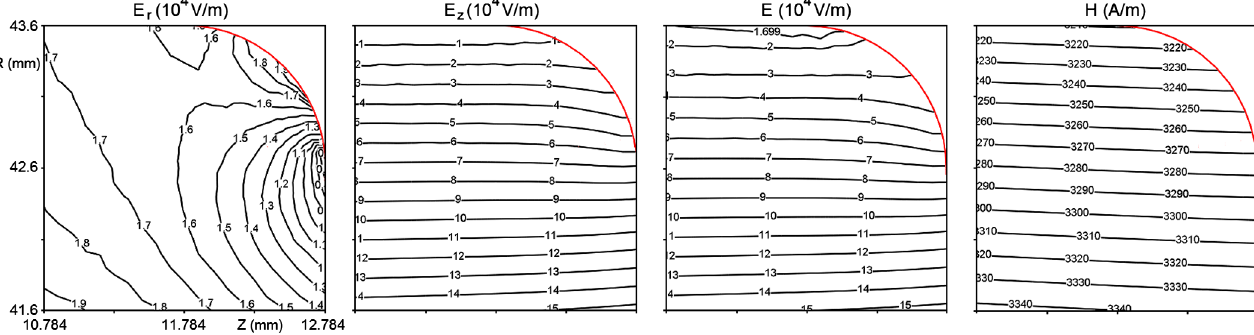
FIG. 4. Electric and magnetic fields near the rounded corner with R ¼ 1 mm